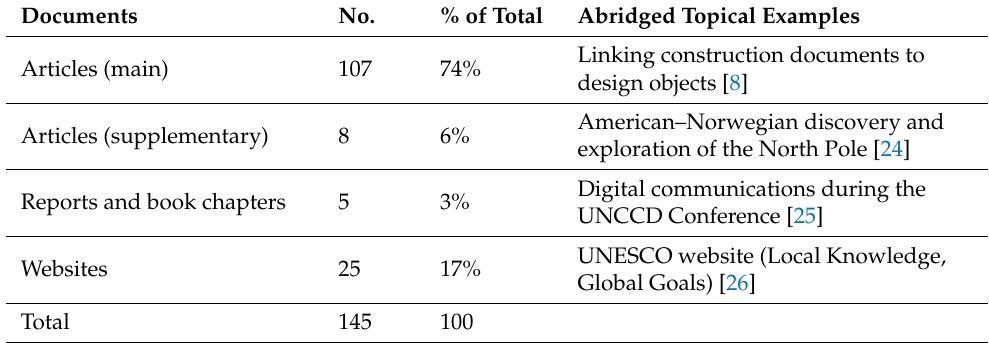
Table 1. Documents used in this review paper.